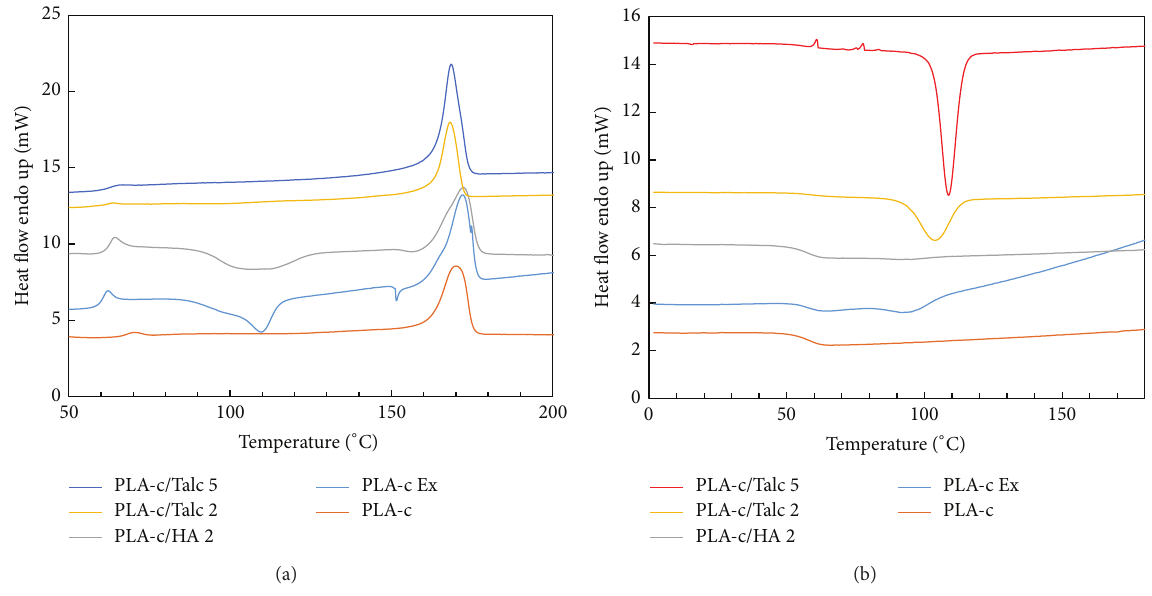
Figure 4: Effect of the weight percent of the filler on DSC result of heating (a) and cooling (b) of semicrystalline PLA